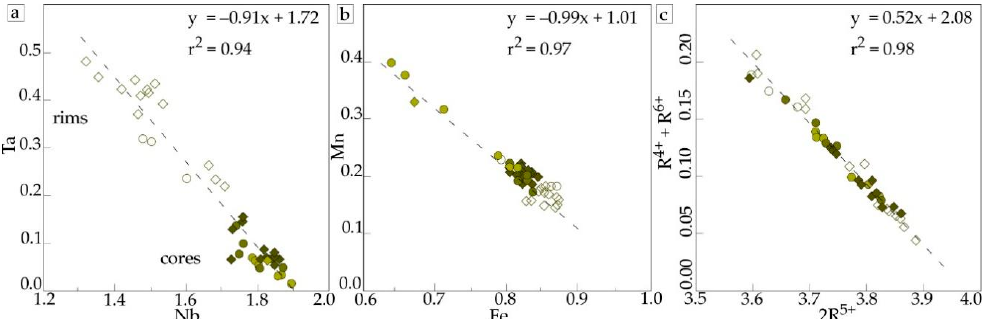
Figure 7. Compositional variations in columbite 1 and 2 crystals from the Desemborque Pluton. ( a ) Ta vs. Nb plot; ( b ) Mn vs. Fe plot; ( c ) R 4+ + R 6+ vs. 2R 5+ plot.